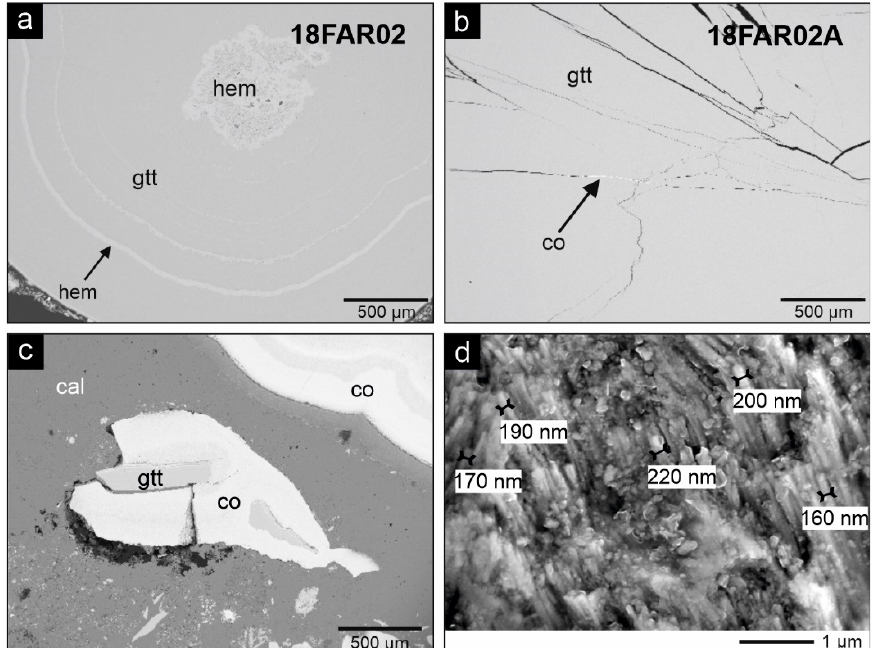
Figure 5. ( a – c ) SEM microphotographs of the most representative samples in back-scattered electron mode. ( d ) SEM microphotograph of botryoidal sample 18PL07. Secondary electron mode with the size of goethite crystallites (width exceeding 100 nm). Gtt = goethite; Hem = hematite; Co = coronadite group minerals; Cal = calcite.